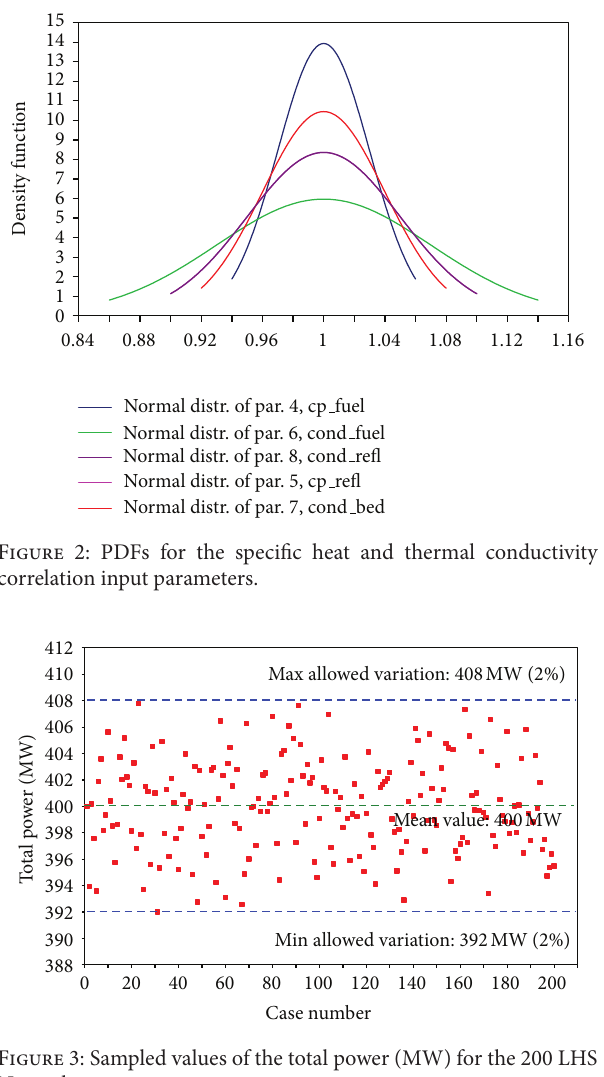
F 3: Sampled values of the total power (MW) for the 200 LHS Normal